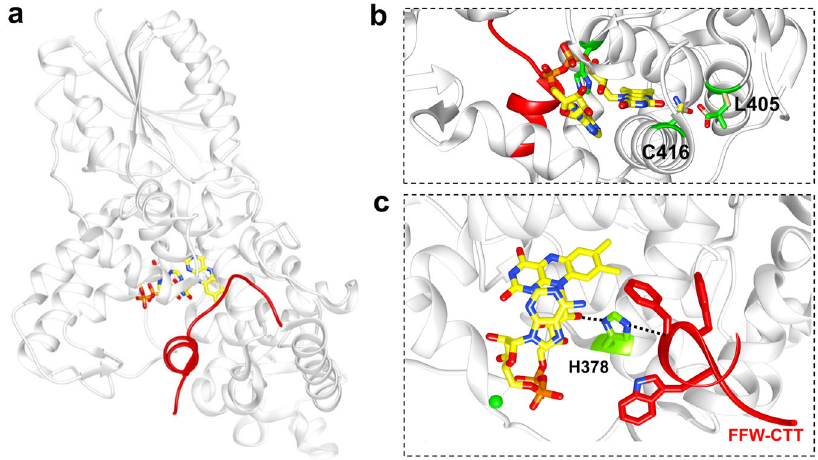
Fig. 1 Structure of dCRY. a The C-terminal tail (CTT) of dCRY (red) binds into the pocket containing FAD (yellow). b C416 (green) interacts with the FAD N 5 to disfavor protonation, whereas L405 blocks the solvent from accessing the fl avin. The N416 and E405 substitutions (tan) favor NSQ formation. The L405E/C416N replacements are located at the distal end from the CTT with the FAD group sandwiched in-between the two sites. c H378 (green) bridges the fl avin (magnesium shown as green spheres) to the FFW motif of the